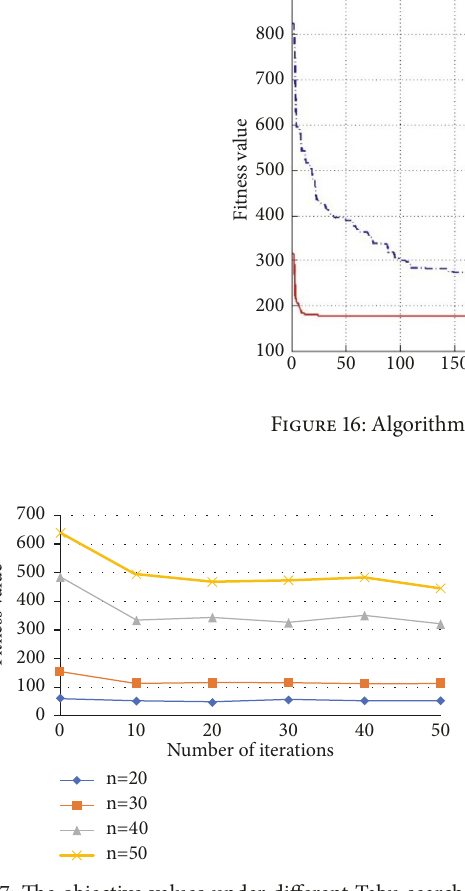
Figure 17: The objective values under different Tabu search itera-